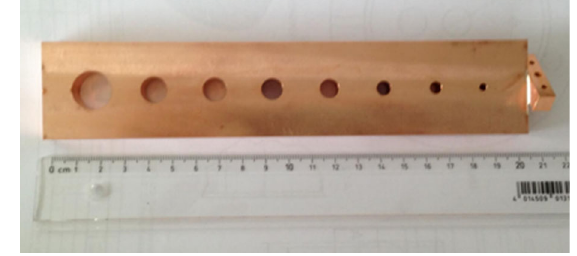
FIG. 17. Collimator array installed at SITF.